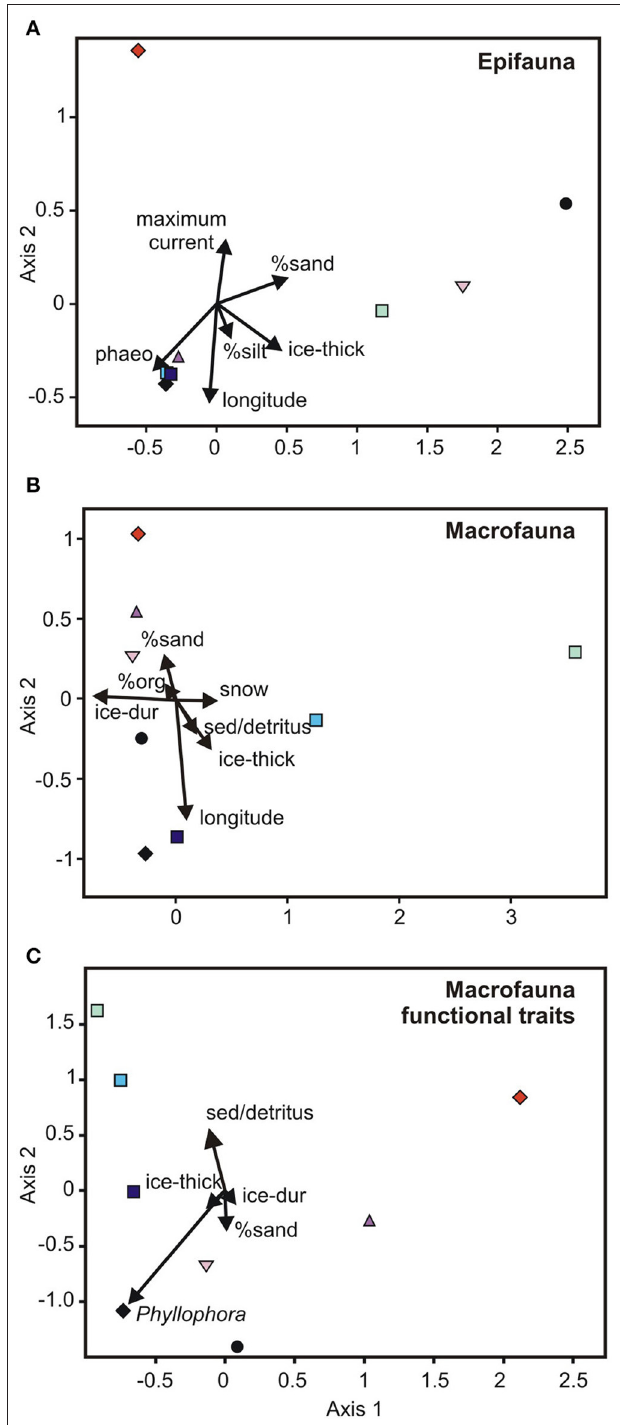
FIGURE 3 | Canonical Correspondence Analysis ordinations of the relationship between habitat and broad scale environmental variables and (A) epifaunal and (B) macrofaunal community composition, and (C) macroinfaunal functional traits. The variation explained by the variables was 97, 95, and 97%, respectively. The locations are represented by different colored symbols as defined in Figure 2 . Phaeo, phaeophytin; ice-thick, ice thickness; ice-dur, ice duration; sed/detritus, sediment associated detritus; org, organic content.